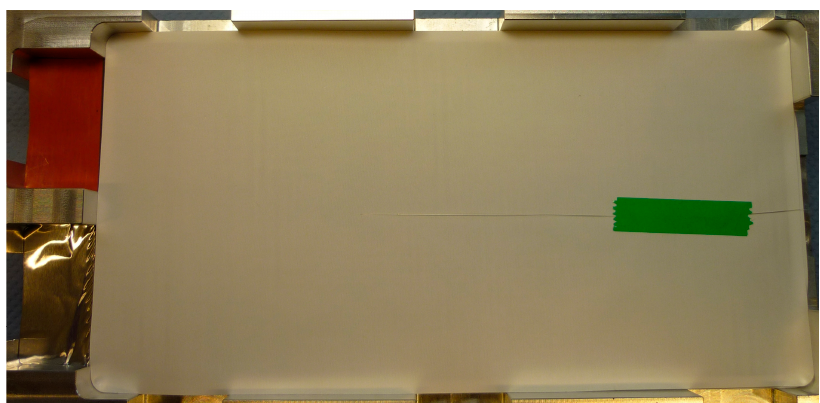
Figure 10. Separator double layer of the lithium ion battery cell used for the experiment. The glass fiber is inserted centrally between the two layers. The surface Bragg grating is located at the end section of the fiber.